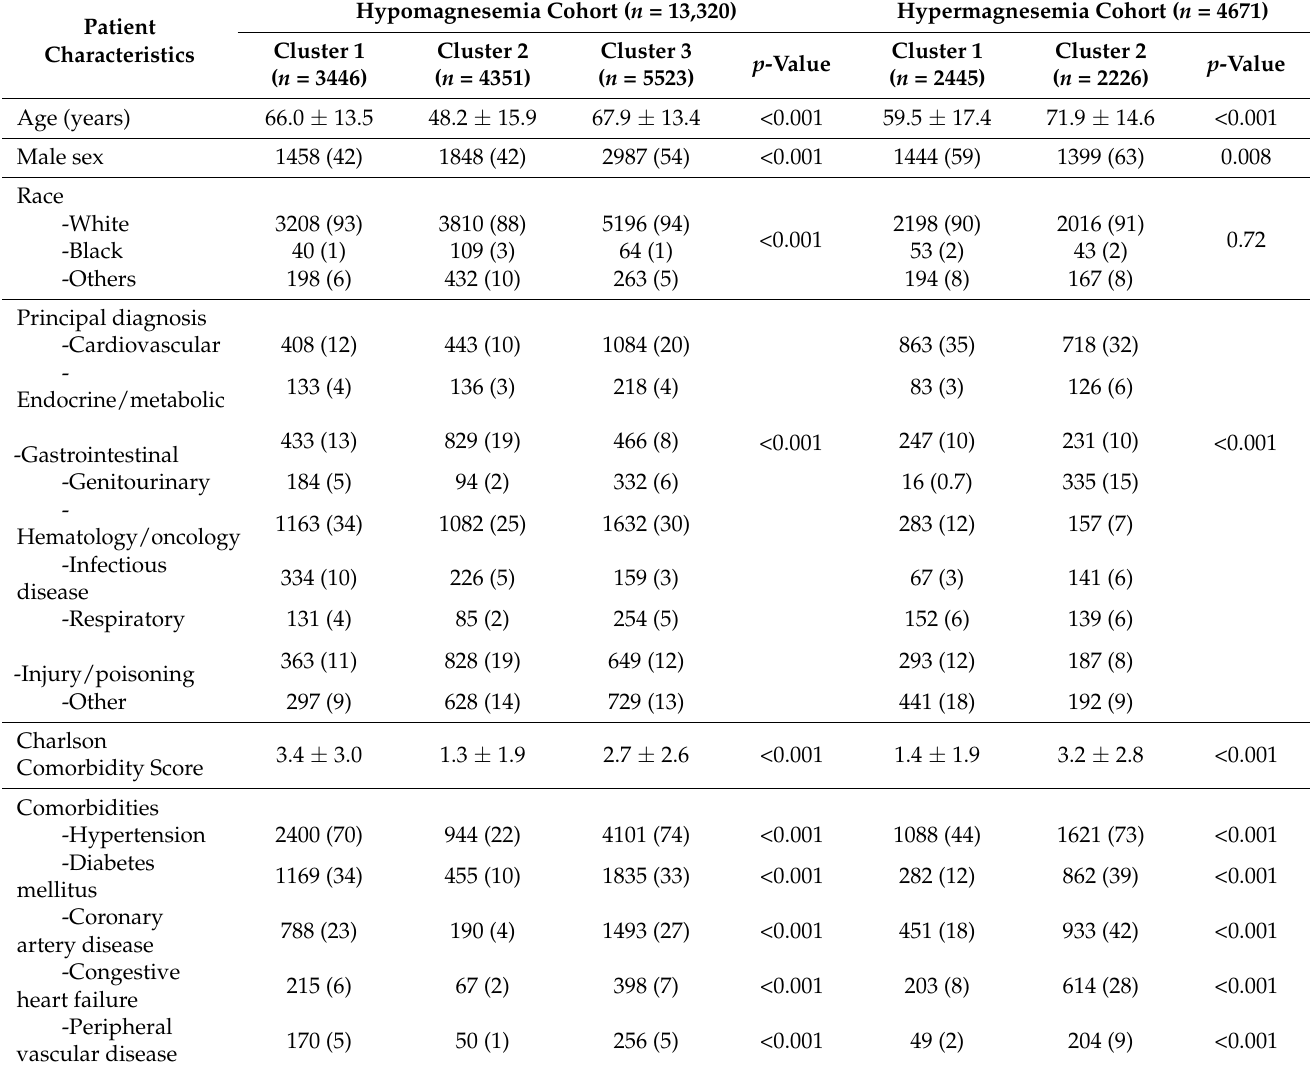
Figure 3. ( A ) The bar plot represents the mean consensus score for different numbers of clusters (K ranges from two to ten) for patients with hypomagnesemia; ( B ) The bar plot represents the mean consensus score for different numbers of clusters (K ranges from two to ten) for patients with hypermagnesemia. Table 1. Clinical